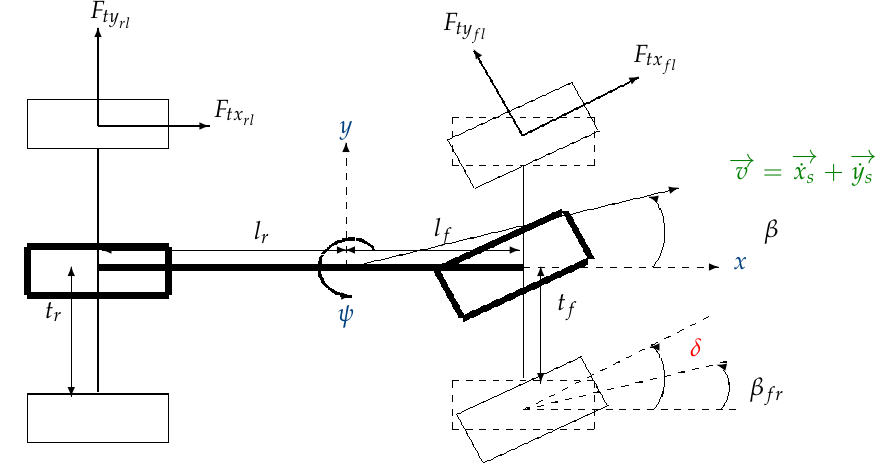
Figure 5. Single track (bicycle) model of the lateral